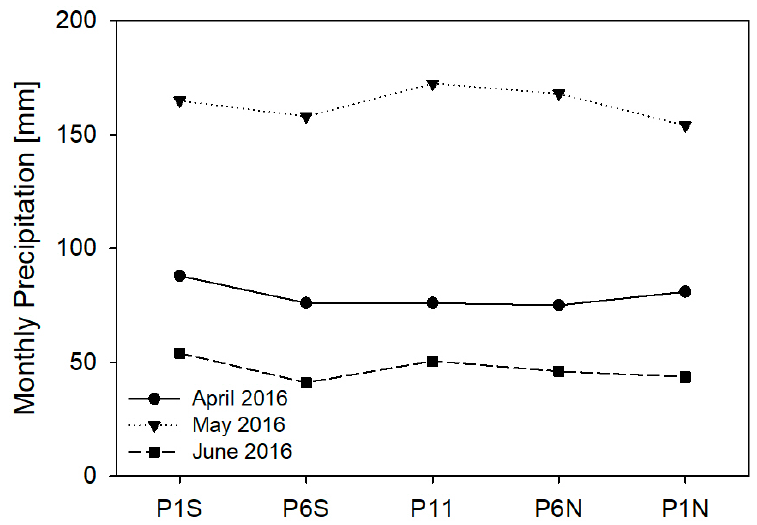
Figure 8. Cumulative monthly precipitation (mm) between April and June 2016 for the five different sample points between the tree rows. Sample points between the tree rows are P1S: 1 m and P6S: 6 m from southern row. P1N: 1 m and P6N: 6 m from northern row. P11: 11 m from southern and northern row, respectively.